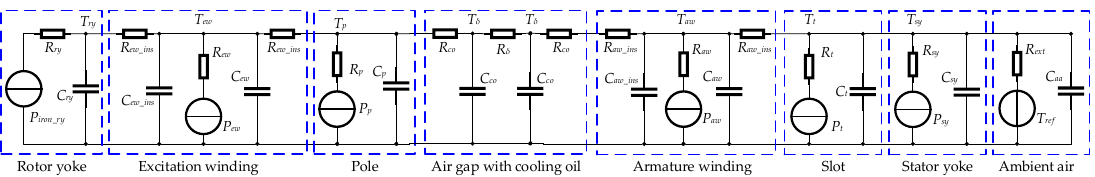
Figure 5. The simplified lumped thermal model of the electrically excited synchronous generator.